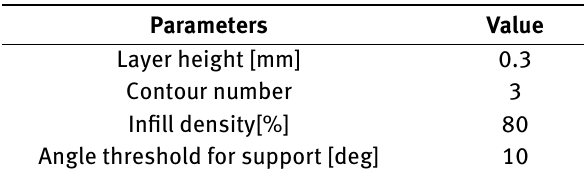
Table 2: FDM parameters selected for the construction of the drone